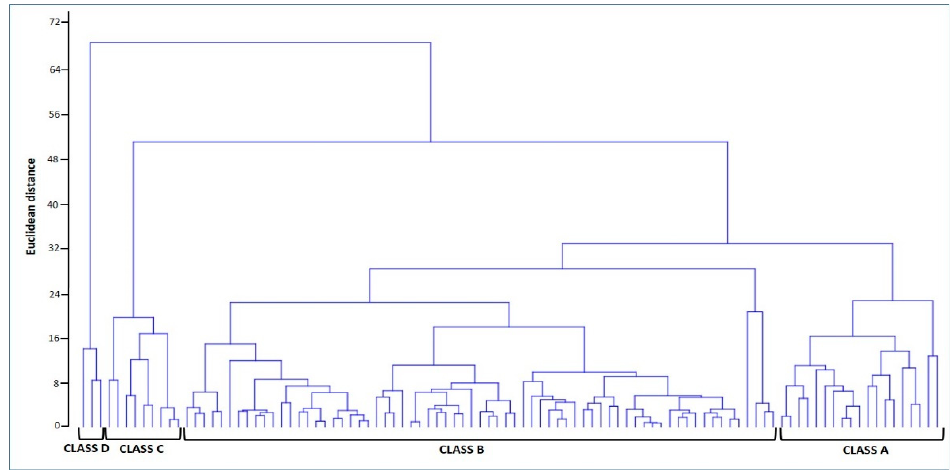
Figure 6. Results of cluster analysis. Four classes have been highlighted and subsequently used to classify the Sentinel-2A image. classify the Sentinel-2A